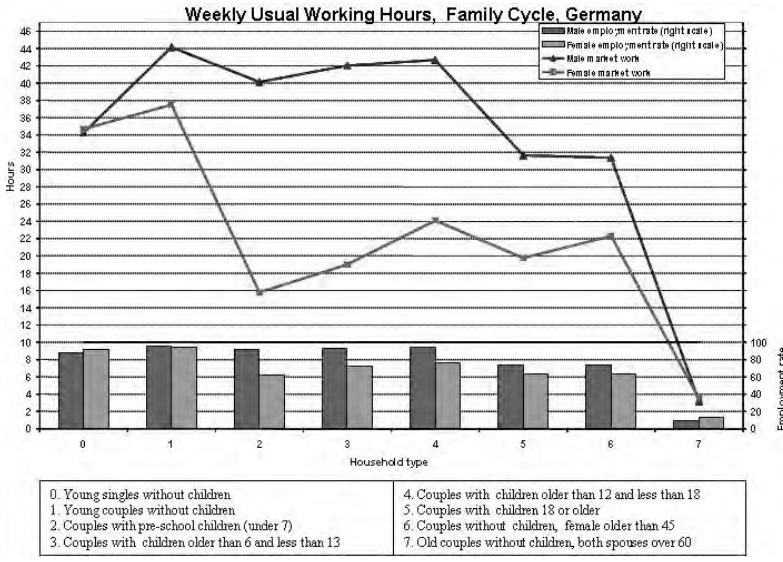
Figure 1: Labour market participation rates and average weekly work hours of men and women during the family cycle: Germany. Note: Average weekly working hours refer to ALL members of the respective household type, including inactive persons (working time = 0 hours).